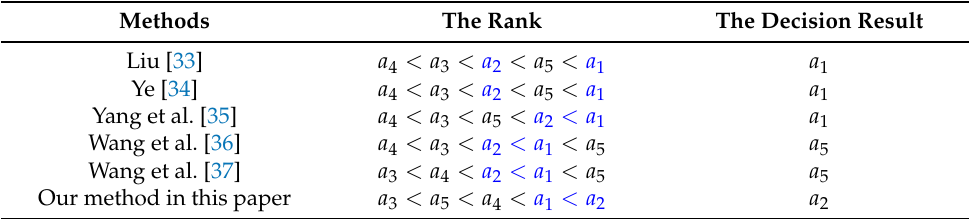
Table 12. The results utilizing the different methods of Table